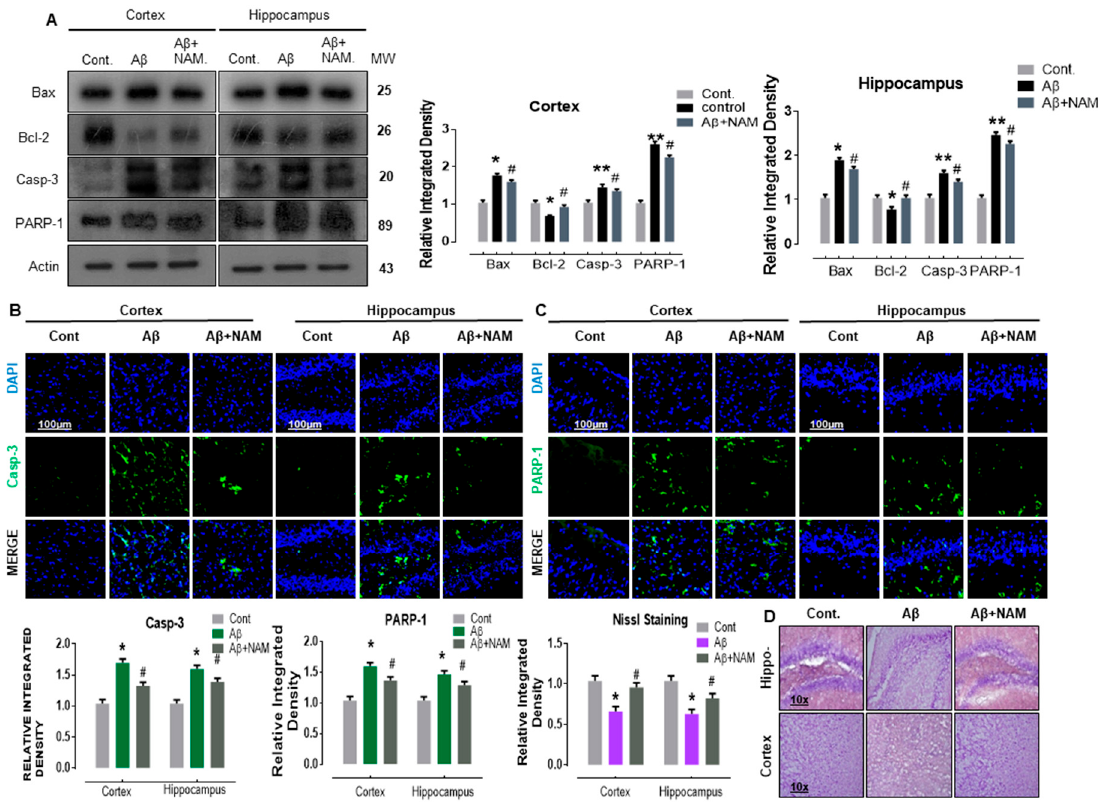
Figure 4. NAM ameliorates A ꞵ 1–42 -induced neurodegeneration in an adult mouse brain. ( A ) Representing the Western blot results of apoptotic markers. ( B , C ) Indicating the confocal results of neuronal apoptotic proteins. ( D ) Represents the Nissl Staining results. Experiments were repeated 3 times. Number of animals were keep 6 for Western blot and 6 for confocal microscopy. Magnification 10 × . Scale bare 100 µ m. Asterisk sign (*) indicated significant difference between control and A β injection group; hash sign (#) indicated significant difference between A β injection group and A β + NAM treated group. Significance: (*) # = p ≤ 0.05, (**) = p ≤ 0.01.